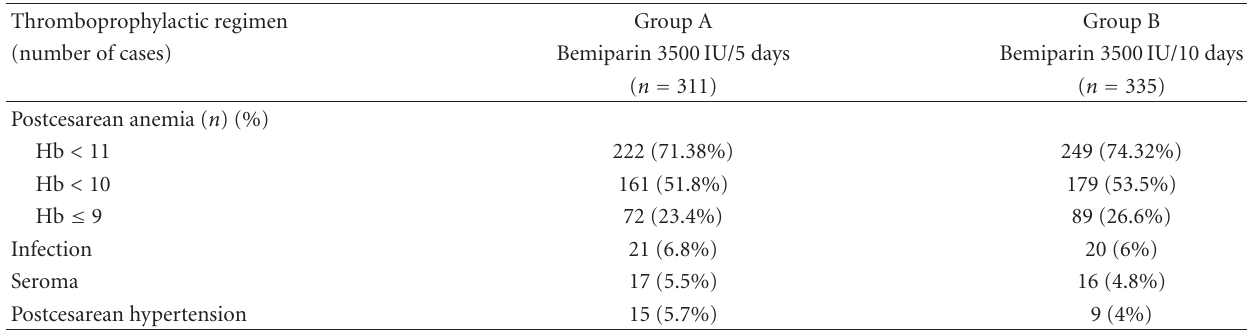
Table 3: Postcesarean thrombosis risk